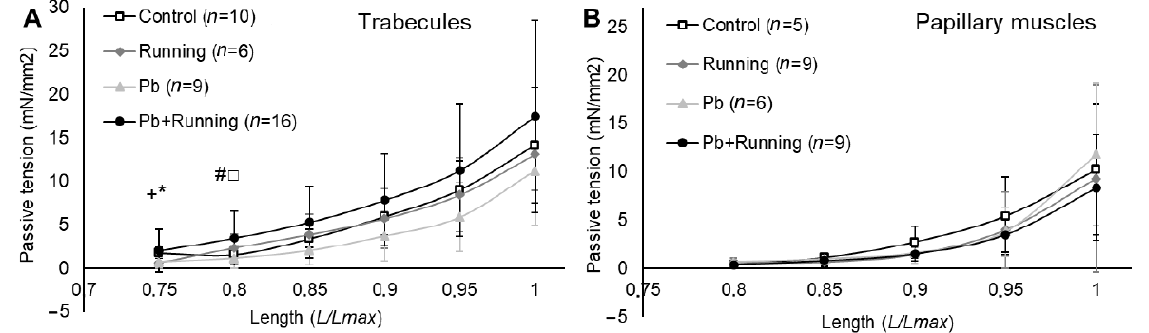
Figure 2. The relationships between passive tension amplitude and relative muscle length of trabecules ( A ) and papillary muscles ( B ) in the experimental groups. The number of preparations is given in brackets. Muscle length is shown in Lmax units. Data are shown as mean ± S.D. There are significant differences (by Mann–Whitney U-test): *—“Running” vs. “Control”; +—“Pb” vs. “Control”; #—”Pb + Running” vs. “Control”; □ —”Pb + Running” vs. “Pb”.